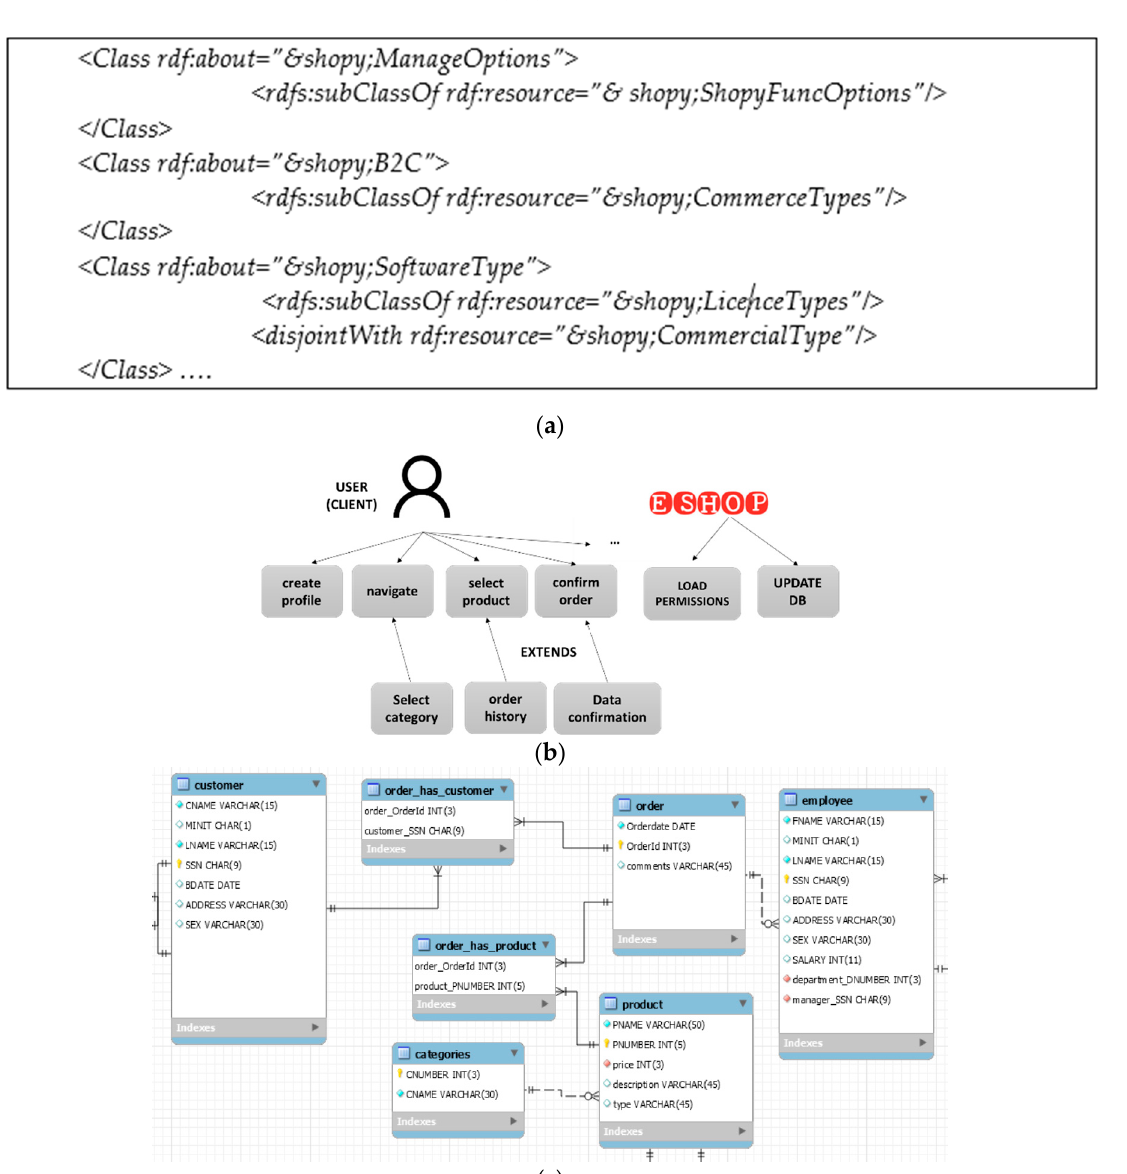
Figure 3. ( a ) Part of the Shopy ontology in RDF/XML; ( b ) part of functional requirements of Shopy system regarding a new client; ( c ) part of the Shopy ER